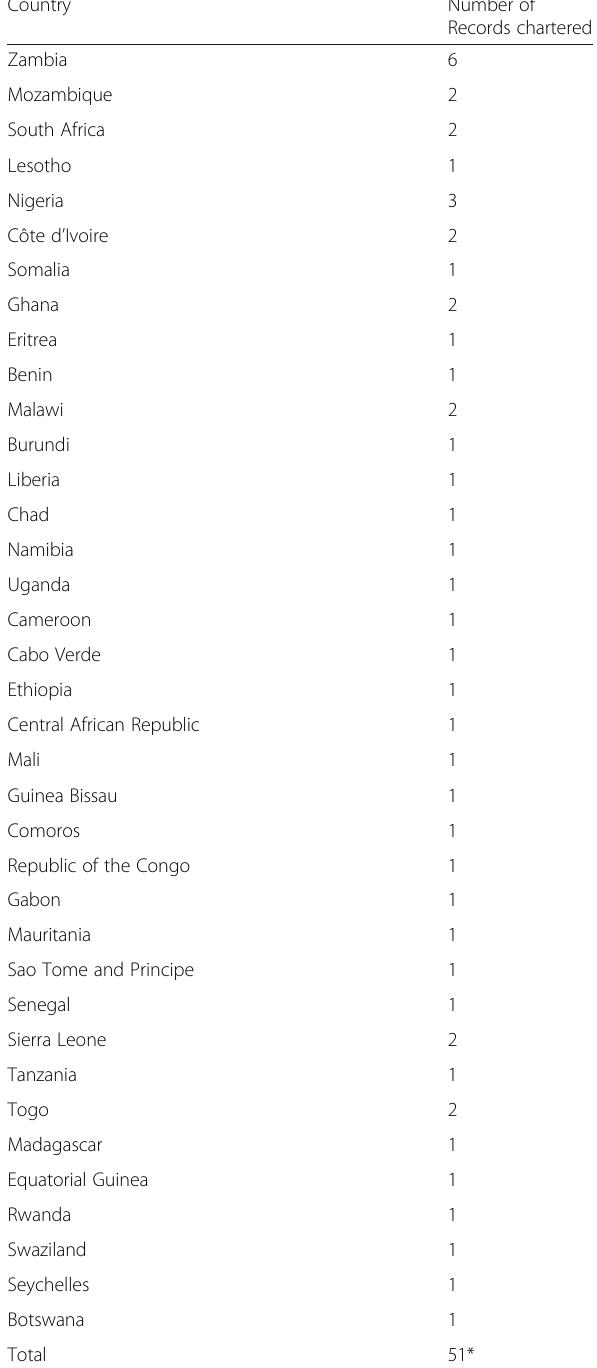
Table 4 Summary table of records per country